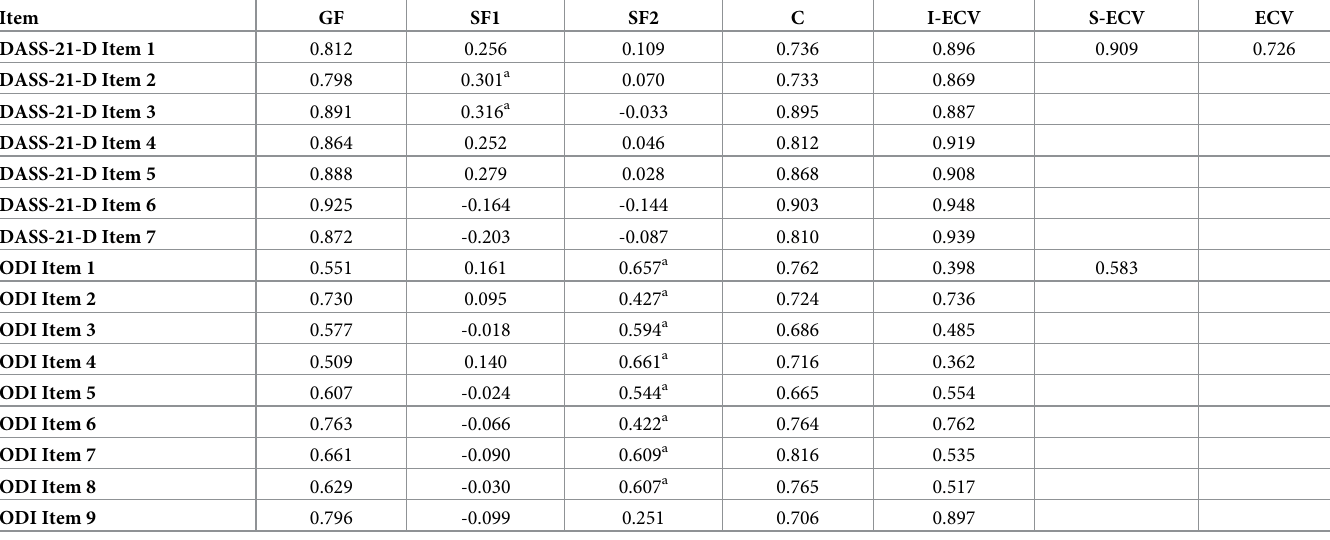
Table 2. Bifactor exploratory structural equation modeling analysis of the Occupational Depression Inventory (ODI) and the Depression subscale of the Depres- sion Anxiety Stress Scales-21